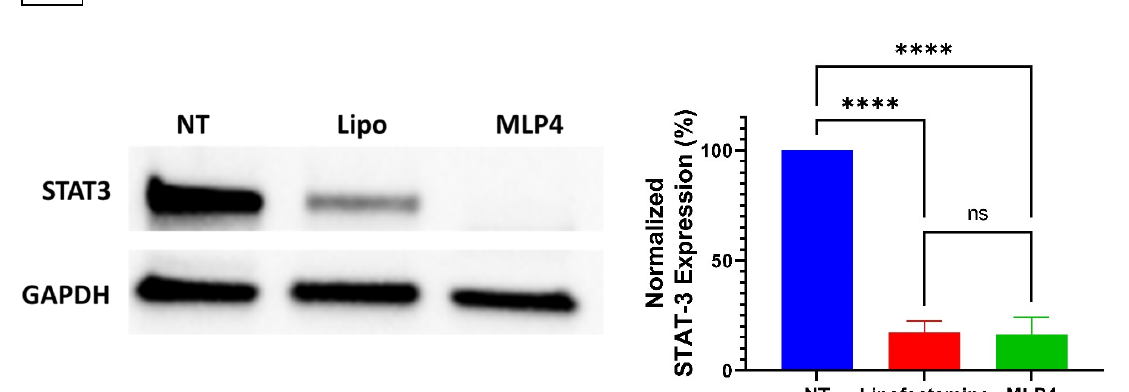
Figure 10. Comparison of STAT 3 protein downregulation efficiencies of lipopeptides at N/P ratios of 40 ( A ) and 20 ( B ) in MDA-MB-231 cells and the downregulation efficiency of MLP4 at a N/P ratio of 20 in SK-OV3 cells ( C ). Error bars indicate standard deviation (n = 3). ns = non-significant, ** p -value < 0.001, and **** p -value <